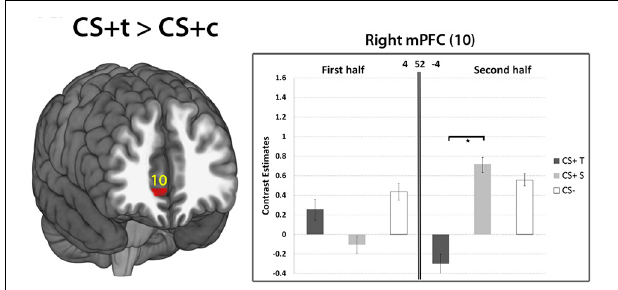
FIGURE 8 | Results of the contrast CS + t > CS + c within the mPFC ROI (10). Whole-brain SPM activations maps are shown with a statistical threshold of p < 0 . 001, uncorrected, voxel threshold = 10. Mean contrast estimates (and standard errors of the mean ± s.e.m.) for early and late phases in the respective peak voxels are illustrated in the bar graph. ∗ p < 0 .